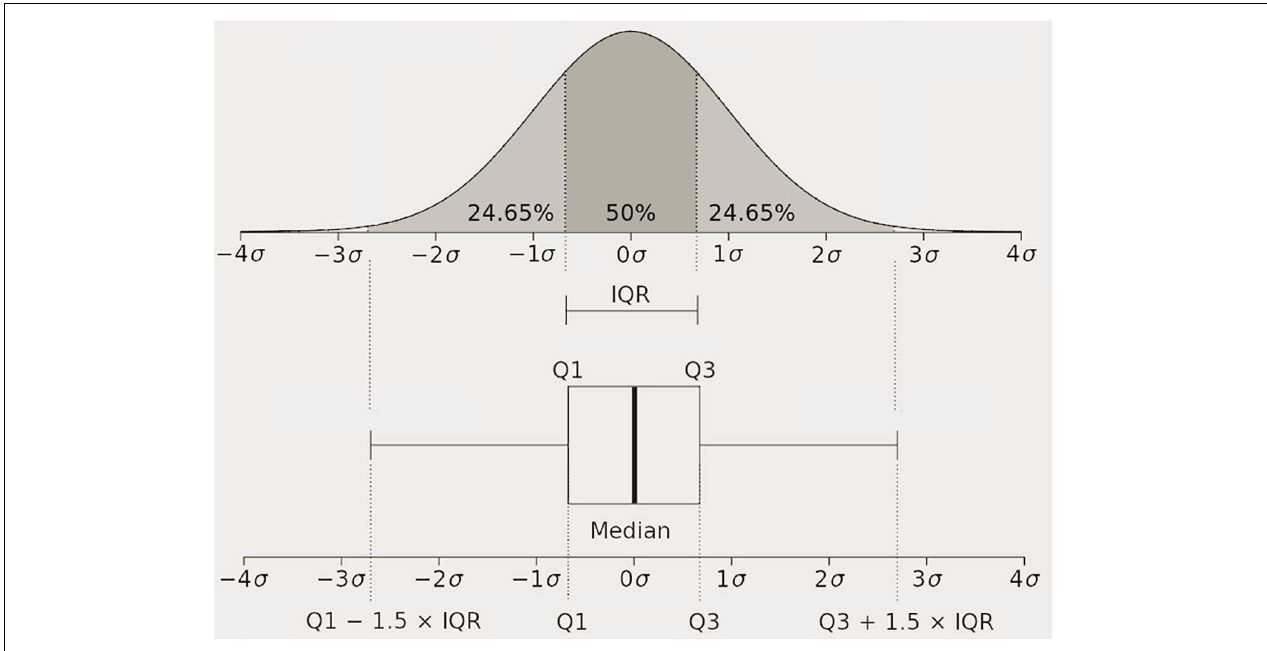
FIGURE 2 | Quartiles (Q ∗ ) and boxplots’ description